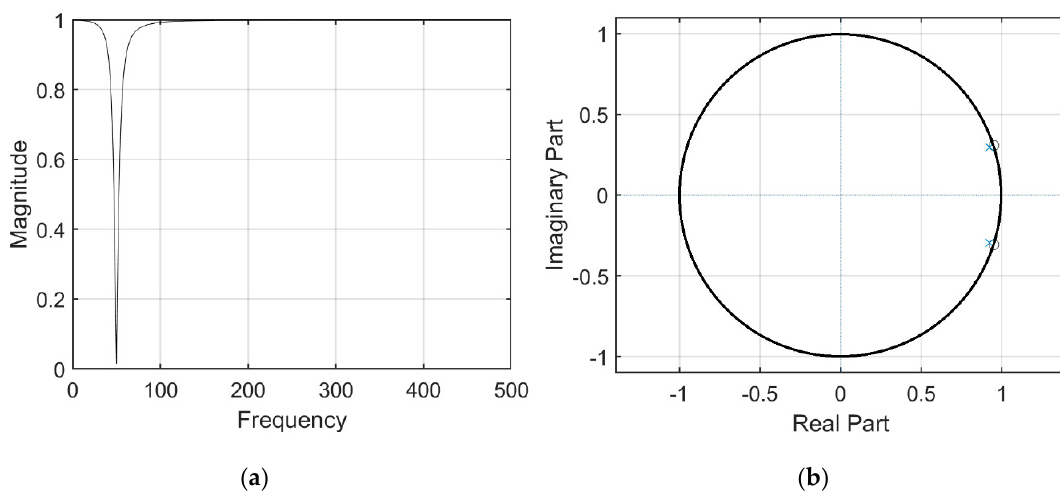
Figure 5. Third-order 50 Hz notch filter with ak = [1.0000–1.8451 0.9391], bk = [0.9695–1.8451 0.9695] and sampling frequency = 1000 Hz: ( a ) frequency response and ( b ) pole-zero pattern plot.